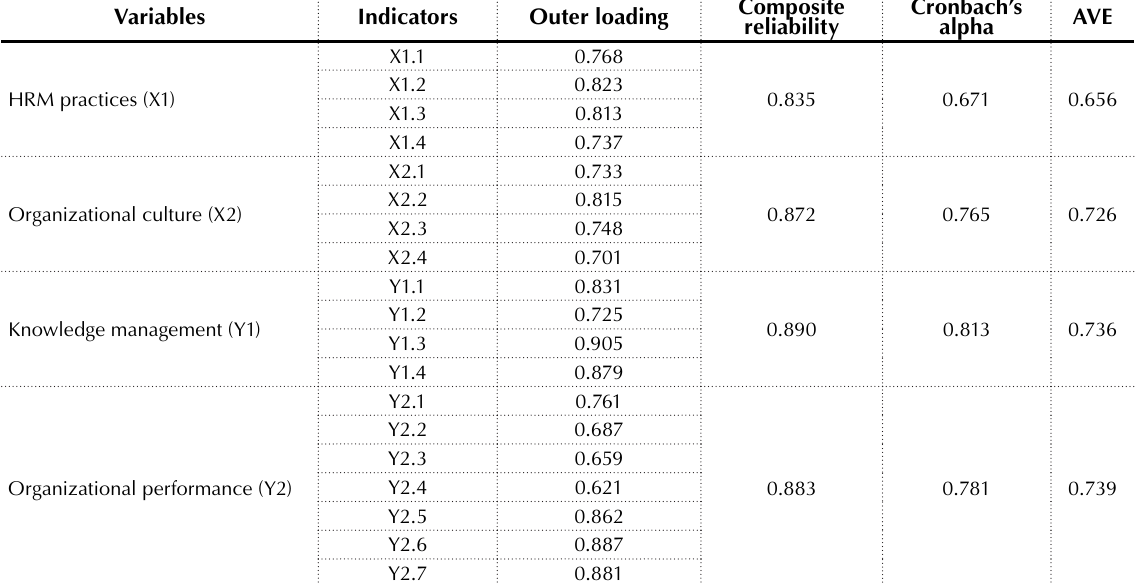
Table 2. Model validity and reliability